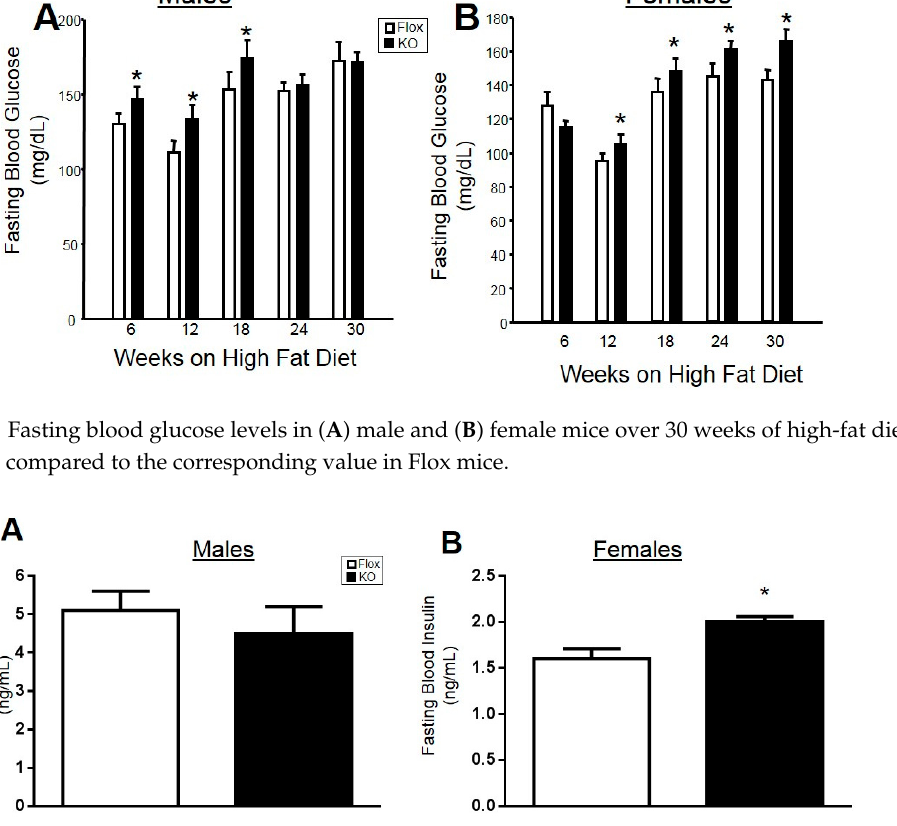
Figure 4. Fasting blood insulin levels in ( A ) male and ( B ) female mice at week 30 of a high-fat diet. * p < 0.05 compared to the corresponding value in Flox mice.